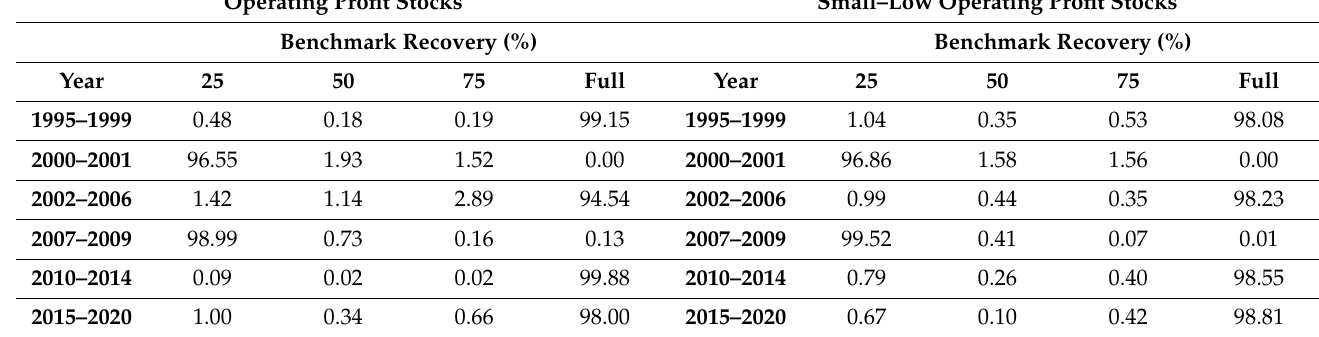
Panel F: Recovery Probabilities for Sharpe Ratio